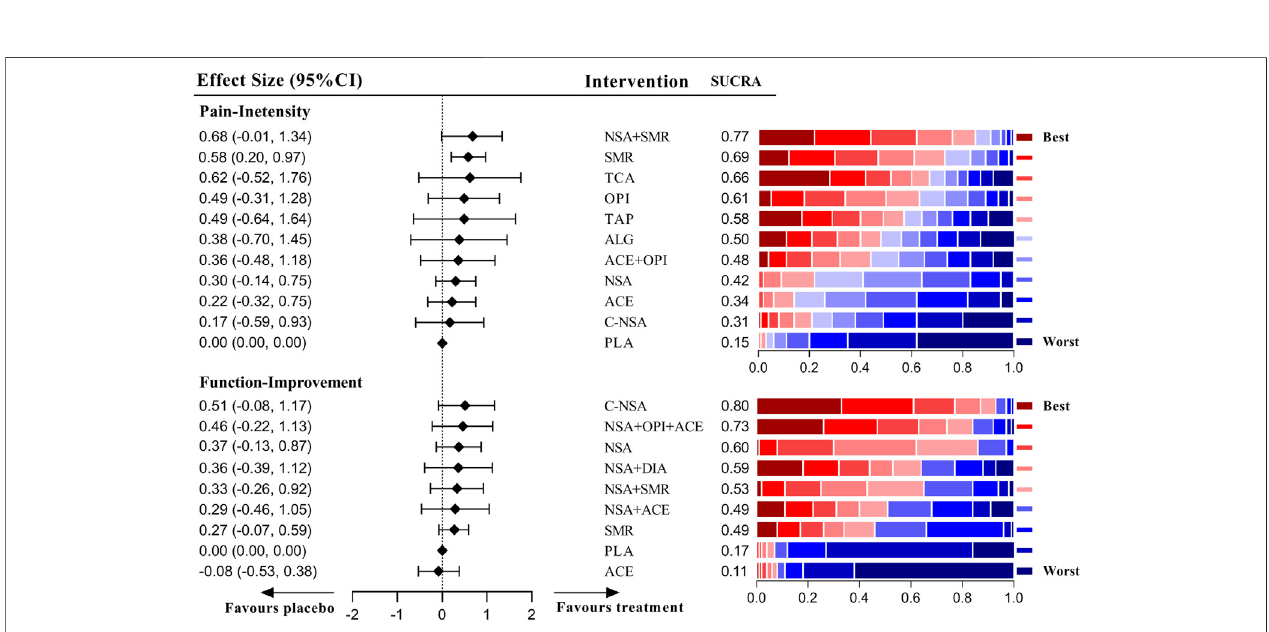
FIGURE 3 | Estimate effects and hierarchy of pharmacotherapies for acute low back pain (LBP).